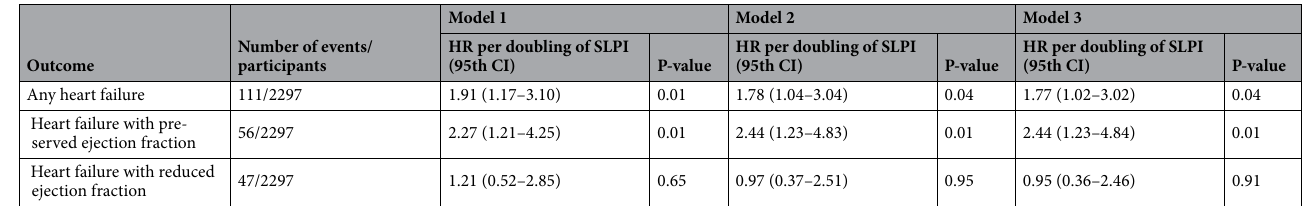
Table 2. Associations of serum SLPI with incident heart failure (including subtypes). Hazard ratios (HR) for heart failure (including subtypes) for each model. The HR is presented as per doubling of SLPI and interpreted as per one unit on the log base 2 scale of SLPI measurement with 95% confidence intervals (CI). Model 1 adjusted for age, race, and gender. Model 2 further adjusted for body mass index (BMI), systolic blood pressure, antihypertensive medication treatment, diabetes mellitus, smoking, total cholesterol, and estimated glomerular filtration rate (eGFR). Model 3 additionally adjusted for C-reactive protein (CRP).